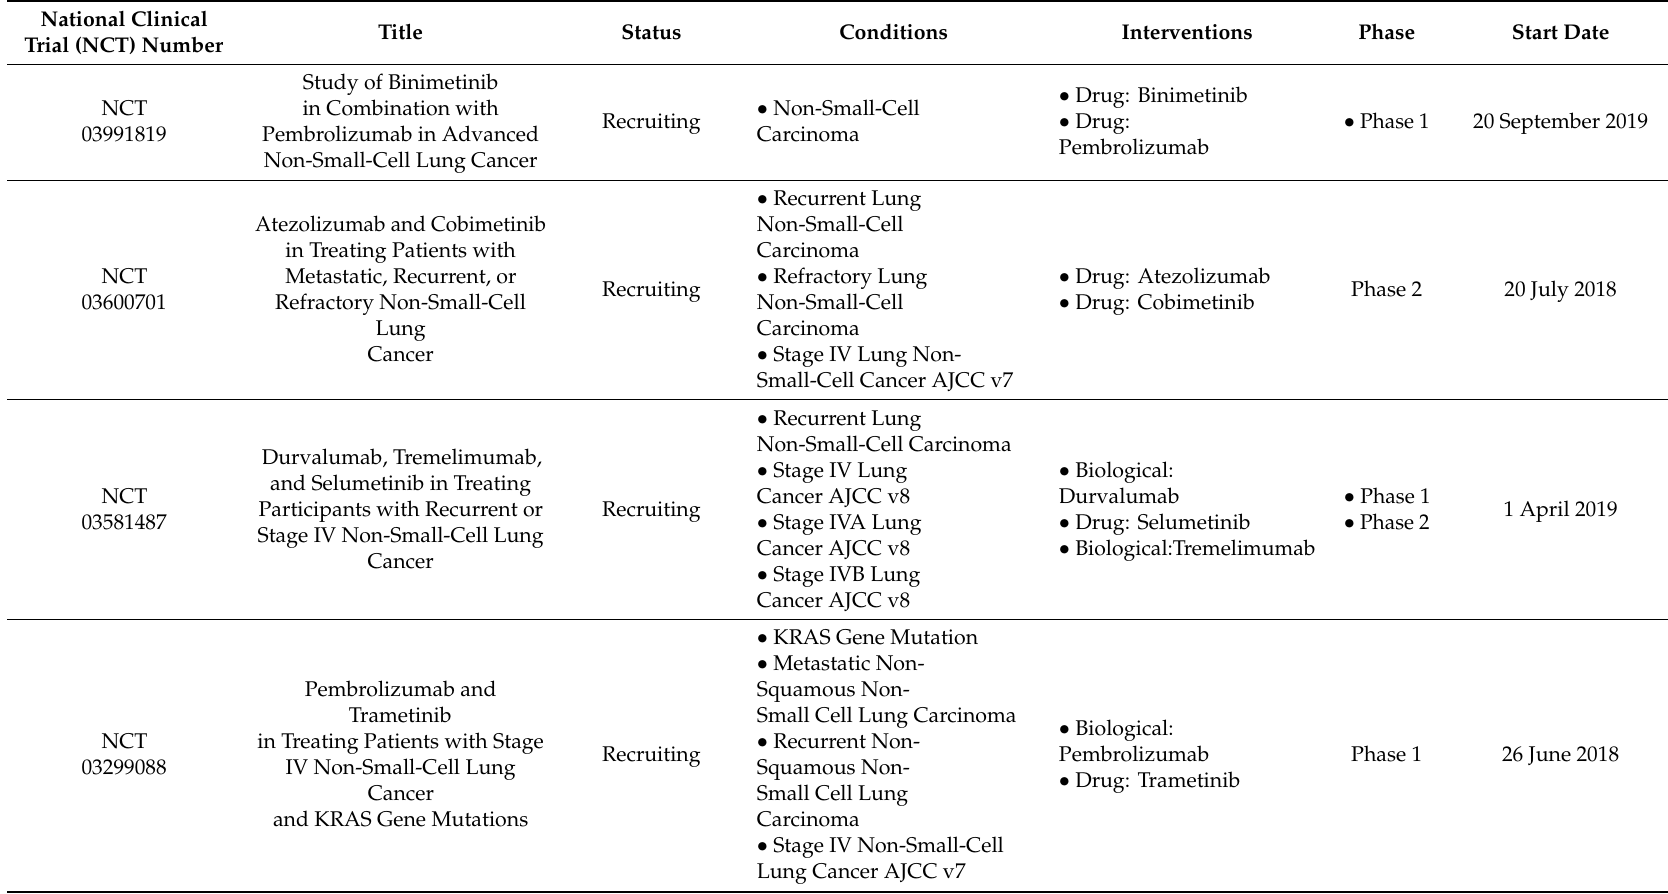
Table 6. Clinical trials of therapies targeting the MAPK pathway and immunotherapies in patients with